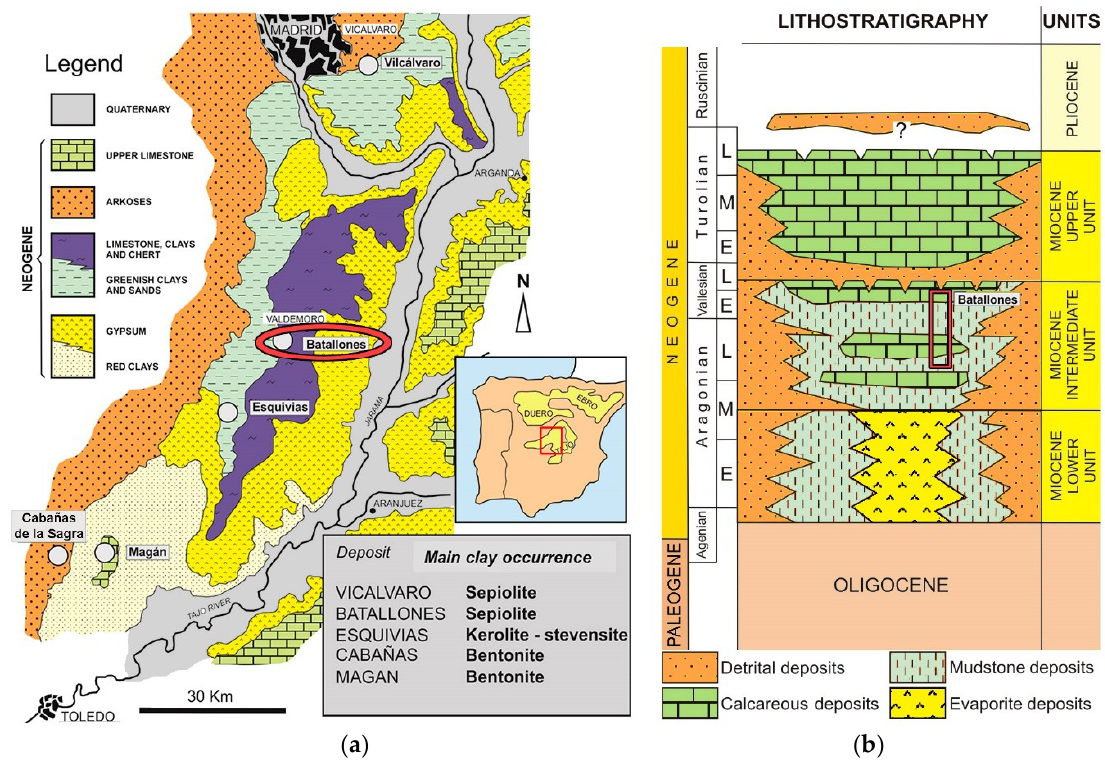
Figure 1. ( a ) Geological map of the Madrid Basin with the location of the Cerro de los Batallones sepiolite deposit (red oval) and other Mg-clay occurrences (modified from Clauer et al. [6]); and ( b ) Neogene stratigraphy of the Madrid Basin (modified from Alonso Zarza and Calvo [7]). The vertical rectangle indicates the stratigraphic location of Cerro de los Batallones lithofacies.